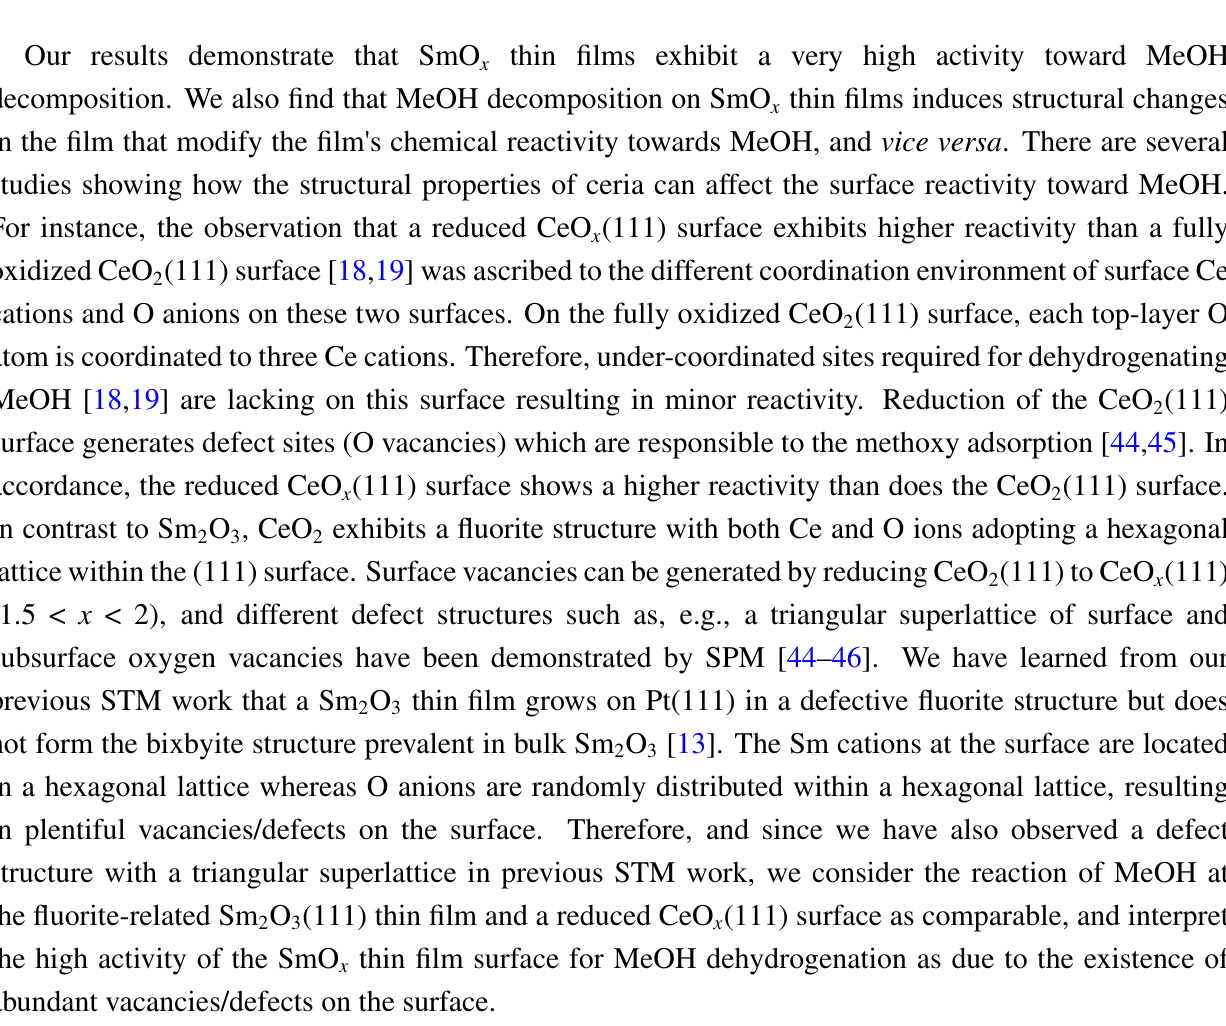
Figure 8. ( a ) Repeated TPD series collected on a 0.9 ML SmO x /Pt(111) surface after the